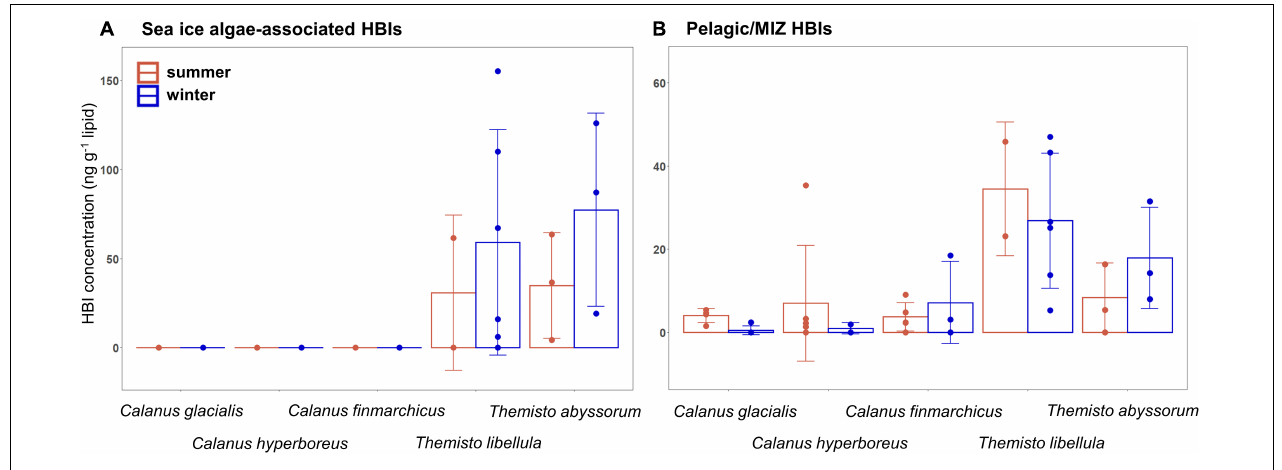
FIGURE 5 | Concentrations of (A) sea ice algae-associated and (B) pelagic/MIZ highly branched isoprenoids (HBIs; mean ± SD ng g − 1 lipid) in copepods and amphipods during summer (Q3) and winter (Q4). Individual datapoints are represented by the dots. Sample size is presented in Table 4 .